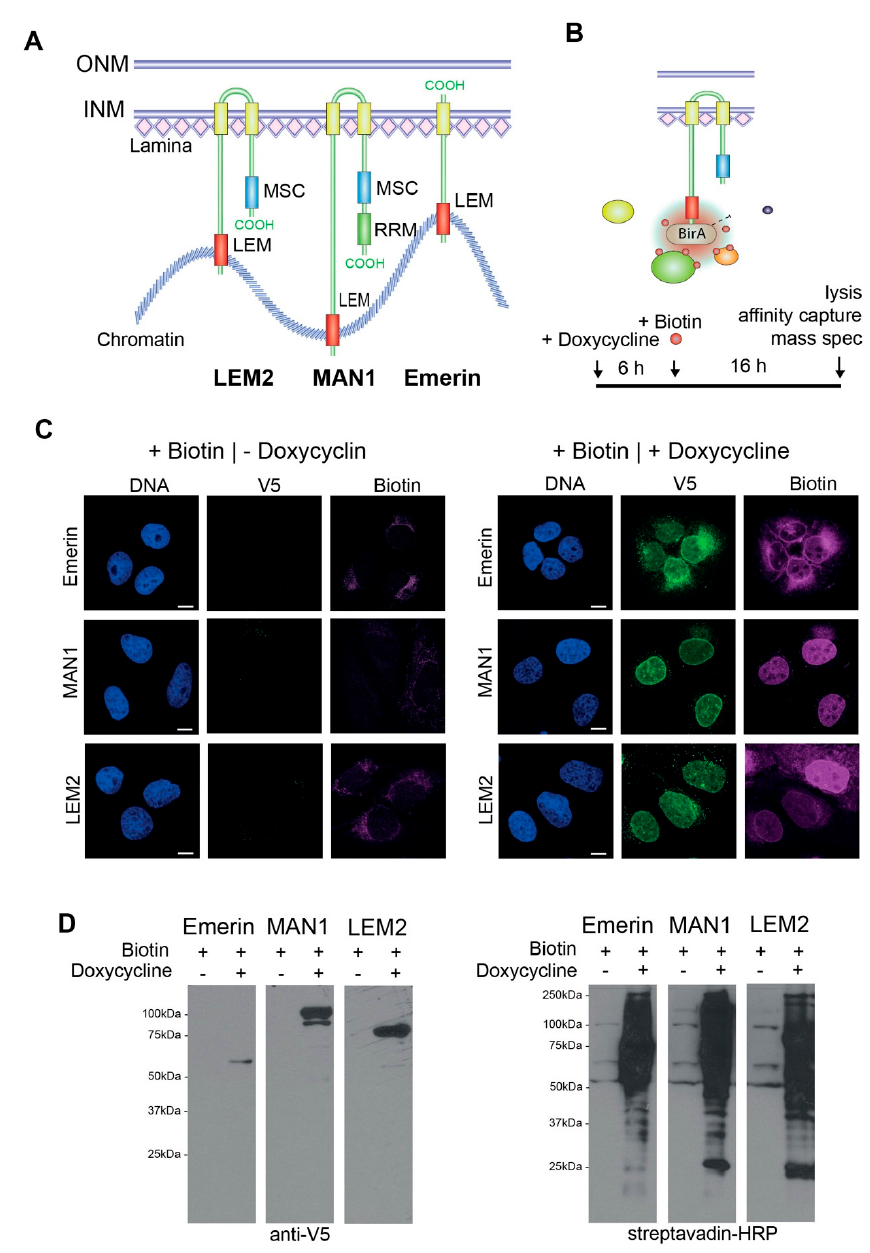
Figure 1. Expression of BirA*-emerin-V5, BirA*-MAN1-V5 and BirA*-LEM2-B-V5 in U2OS cells. ( A ) Schematic domain organization of LEM2-, MAN1- and emerin. Yellow, transmembrane domain; blue, MSC- (MAN1-SRC1p-C-terminal) domain; red, LEM-domain; green, RNA recognition motif (RRM). ( B ) BirA* fusion proteins biotinylate proteins in close proximity (10 nm). Cartoon and time course showing the BioID approach. Cells were incubated with medium containing 1 µ g / ml doxycycline to induce fusion protein expression, 50 µ M biotin was added after 6 h and incubated for another 16 h before cells were lysed. ( C ) U2OS cells stably expressing doxycycline-inducible BirA*-fusion constructs were incubated without (-Doxycycline) or with ( + Doxycycline) doxycycline and biotin and processed for immunofluorescence microscopy using antibodies to the V5 tag and fluorescently labeled streptavidin (biotin). DNA was stained with DAPI. Bar, 10 µ m. ( D ) Total cell lysates of incubated cells were prepared and analyzed by immunoblotting using V5-antibody and horseradish peroxidase (HRP)-conjugated streptavidin. Lanes in Figure 1D were on the same blot (see supplementary Figure S1 for unedited immunoblot) and were generated with identical exposure